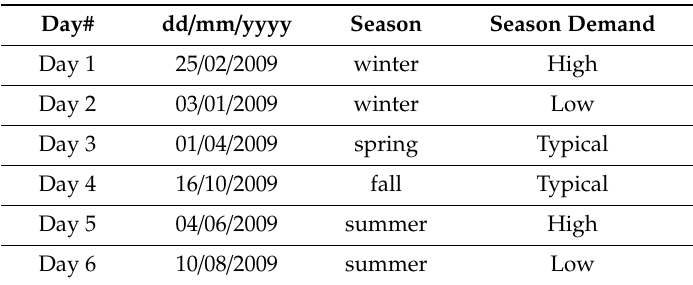
Table 2. The six load curves studied.